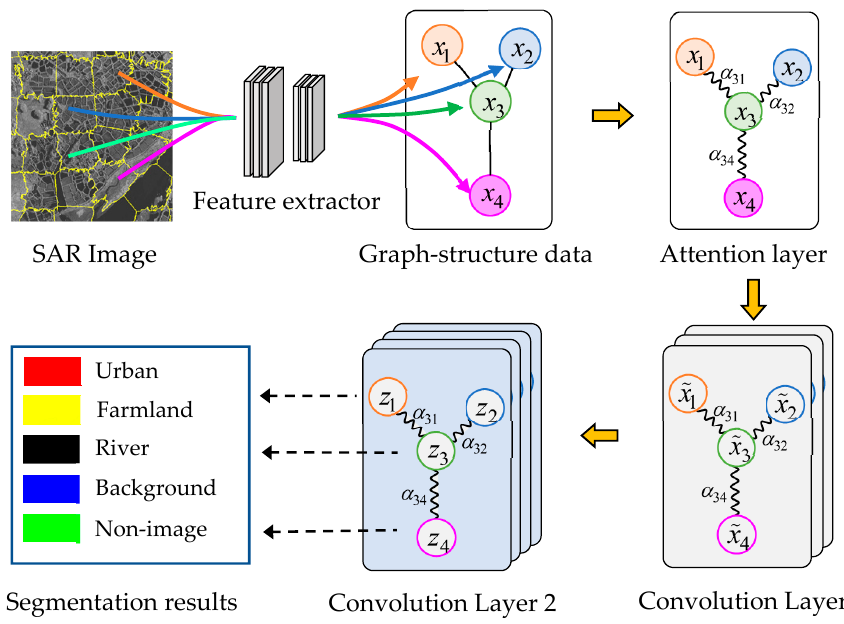
Figure 1. Architecture of our SAR image segmentation approach based on Attention Graph Convolution Network (AGCN).